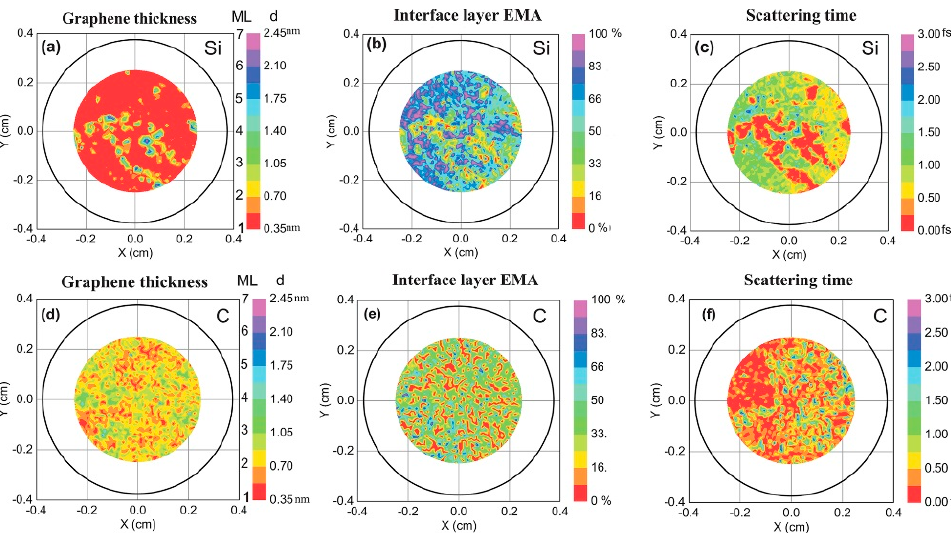
Figure 41. The µ-SE maps of best-match model parameters for graphene layer thickness ( a , d ), interface-layer SiC percentage ( b , e ), and free-charge-carrier scattering time ( c , f ) for EG grown on Si face ( a , b , c ) and C face ( d , e , f ) of 3C-SiC [95].